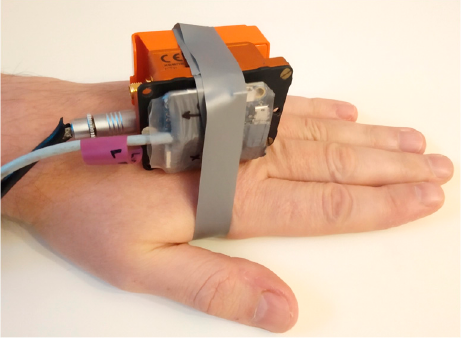
Figure 19. The MTi G-700 sensor and the set of sensors connected to the palm: MTi-G700 sensor, Xsens Awinda wireless sensor, and flight controller sensor.